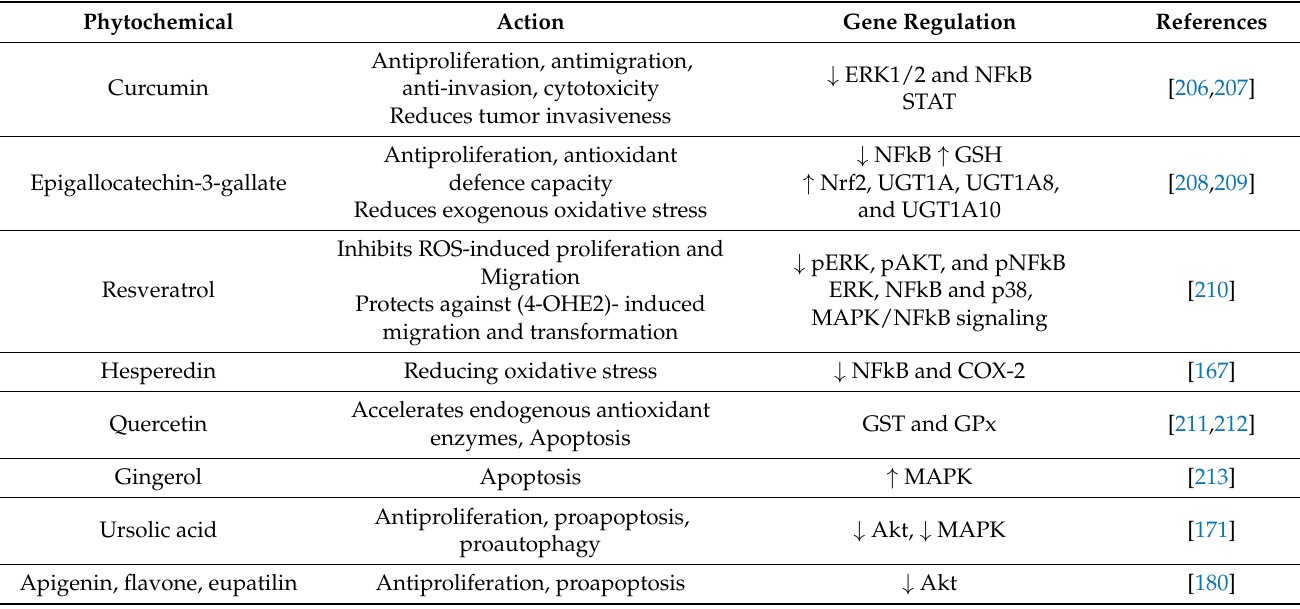
Table 3. Gene regulatory mechanisms of